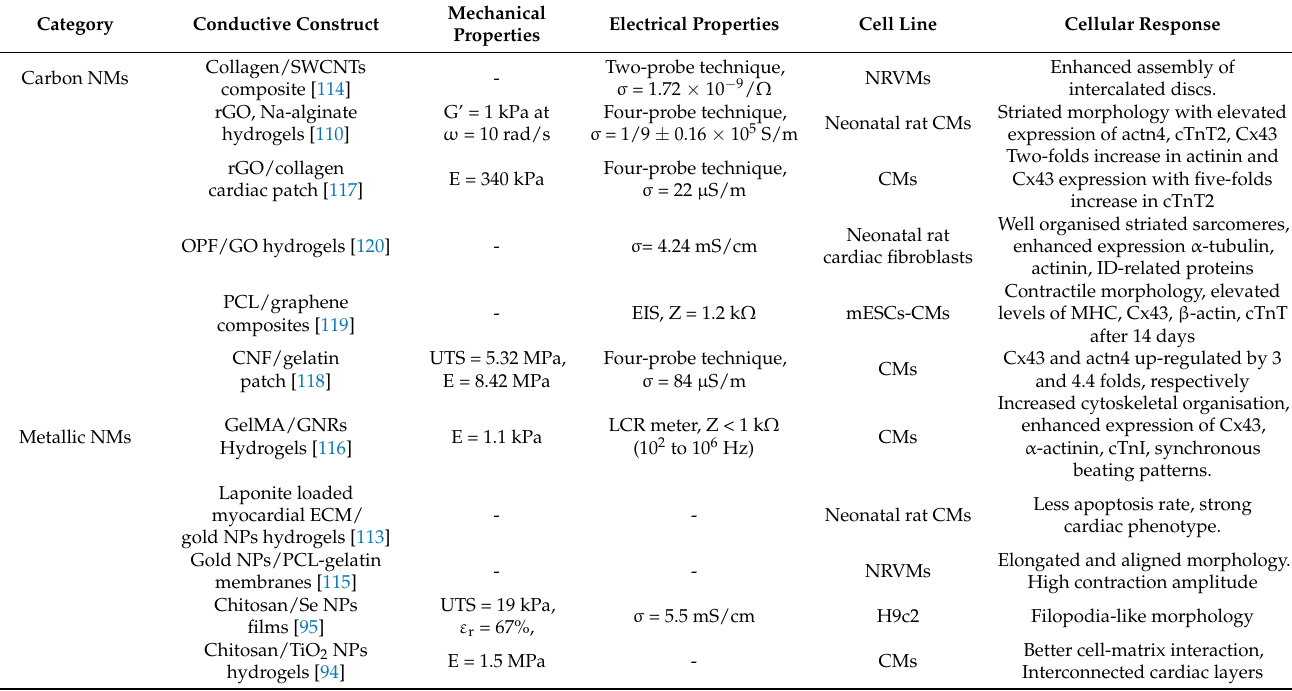
Table 4. Effect of conductive nano-construct on cell